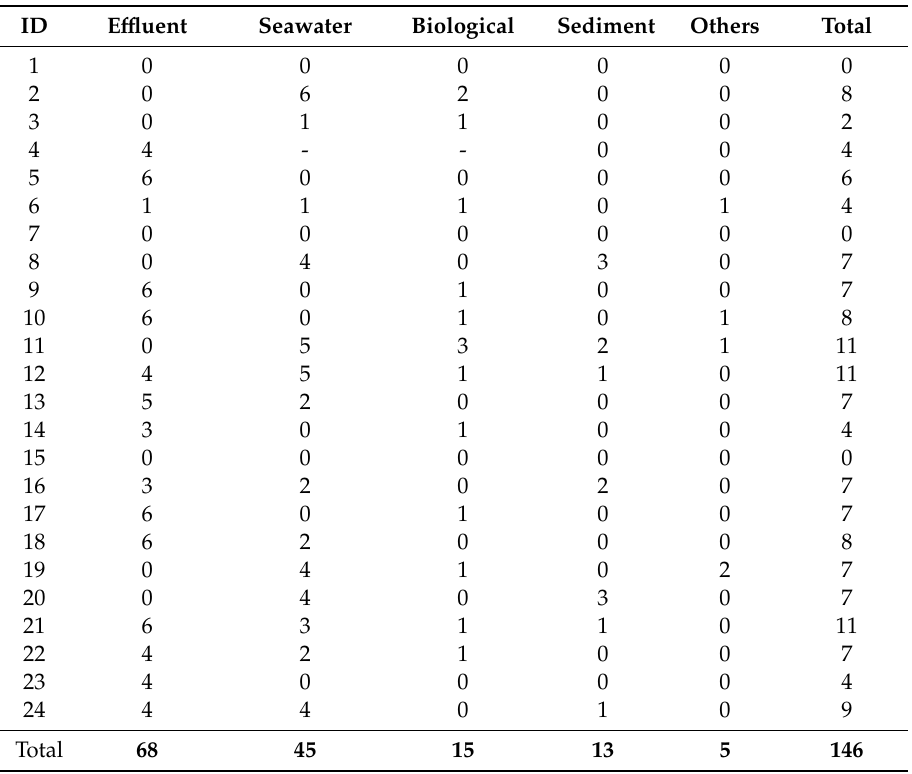
Table 4. Irrelevant parameters identified in EMPs for each